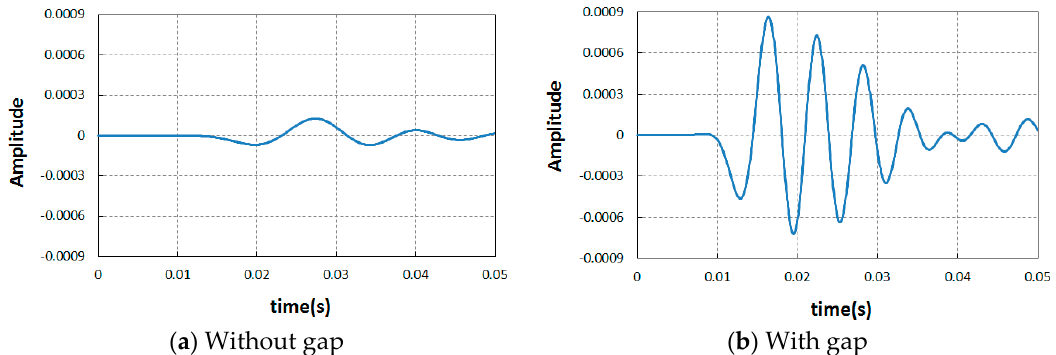
Figure 4. Variation of acceleration amplitude with time in the air 0.4 m above the concrete surface. ( a ) Without gap. ( b ) With gap.